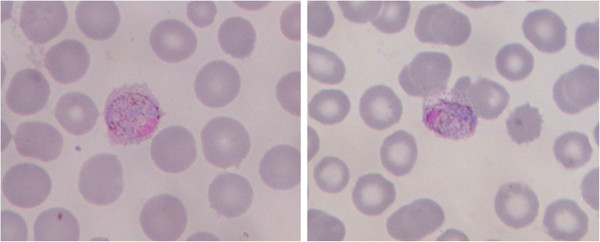
Blood smears showing parasitized erythrocytes by P. ovale in two malaria patients. The two patients with febrile illness attended a malaria clinic at the China-Myanmar border and were diagnosed for malaria. Both cases were only detected by PCR but missed by microscopy and RDTs.